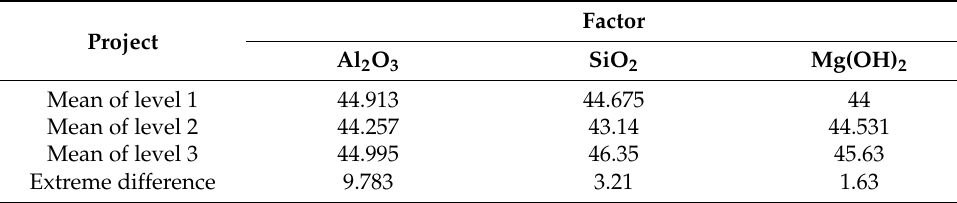
Table 7. Mean and extreme difference analysis of leakage current of each factor ( µ A).